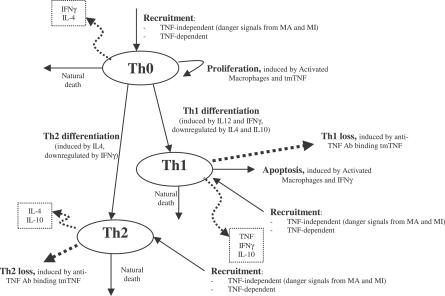
CD4+ T Cell DynamicsDescriptive diagram of lymphocyte dynamics implemented in the mathematical model in Equations 4–6.